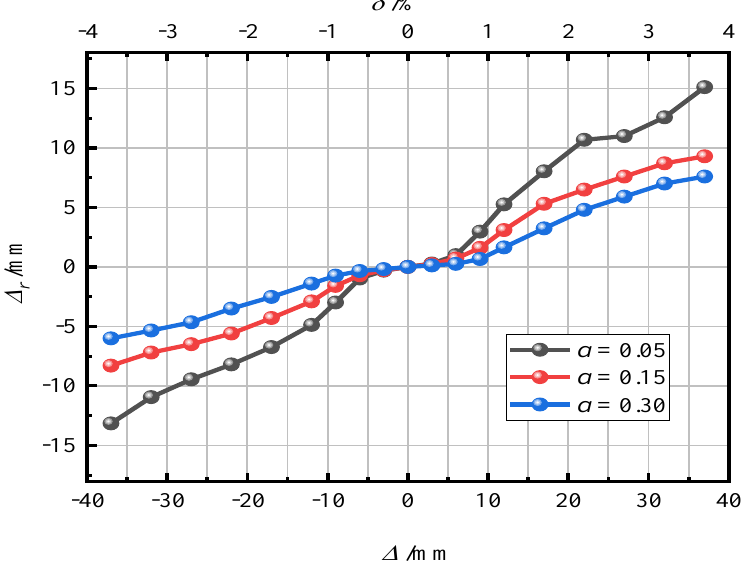
Figure 16. Residual displacement.